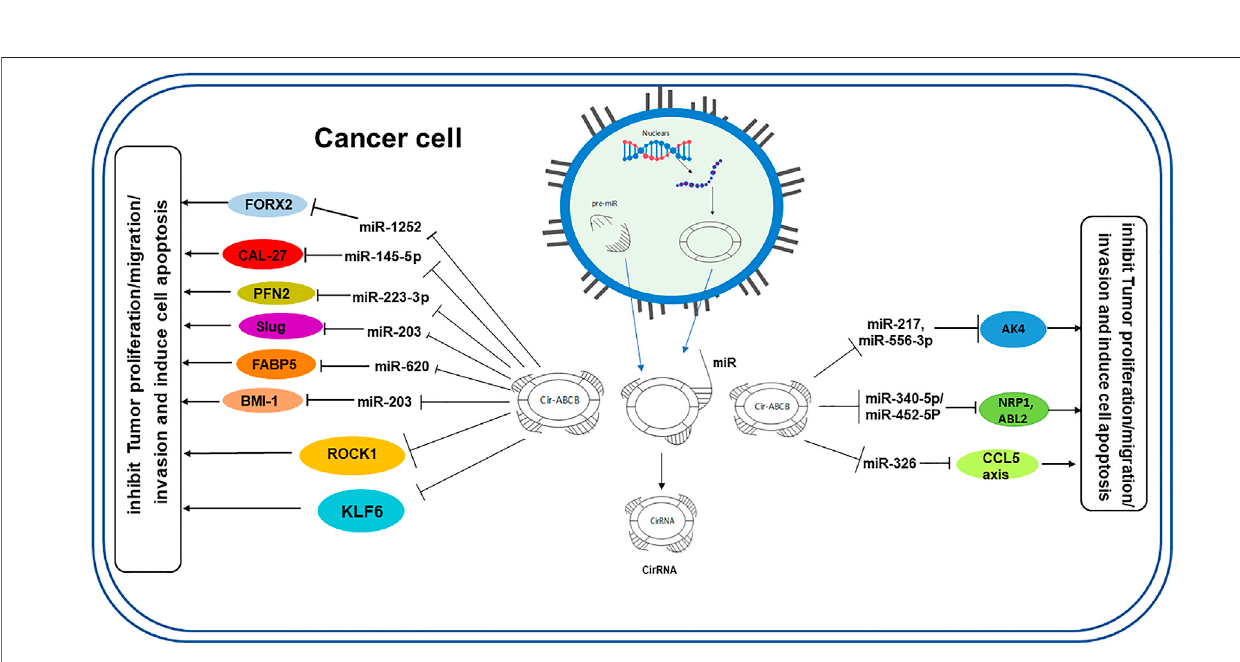
Frontiers in Cell and Developmental Biology |